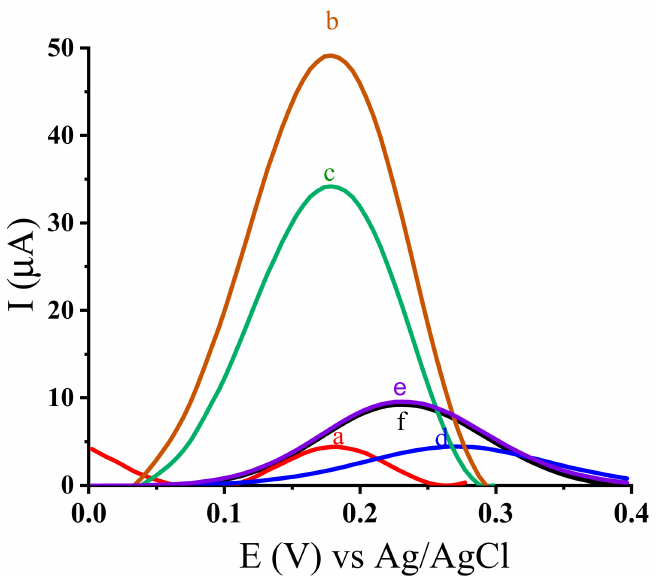
Figure 3. DPV of 1 mM [Fe(CN) 63 − /4 − ] using pyrrole@sol-gelMIP/FMWCNT/ITO electrode (a) be- fore NLX extraction, (b) after NLX extraction, (c) following 5 min incubation with 6 µ M NLX. Curve (d) was obtained using as prepared pyrrole@sol-gelNIP/fMWCNT/ITO, curves (e & f) were obtained following NLX extraction and 5 min incubation with 6 µ M NLX,